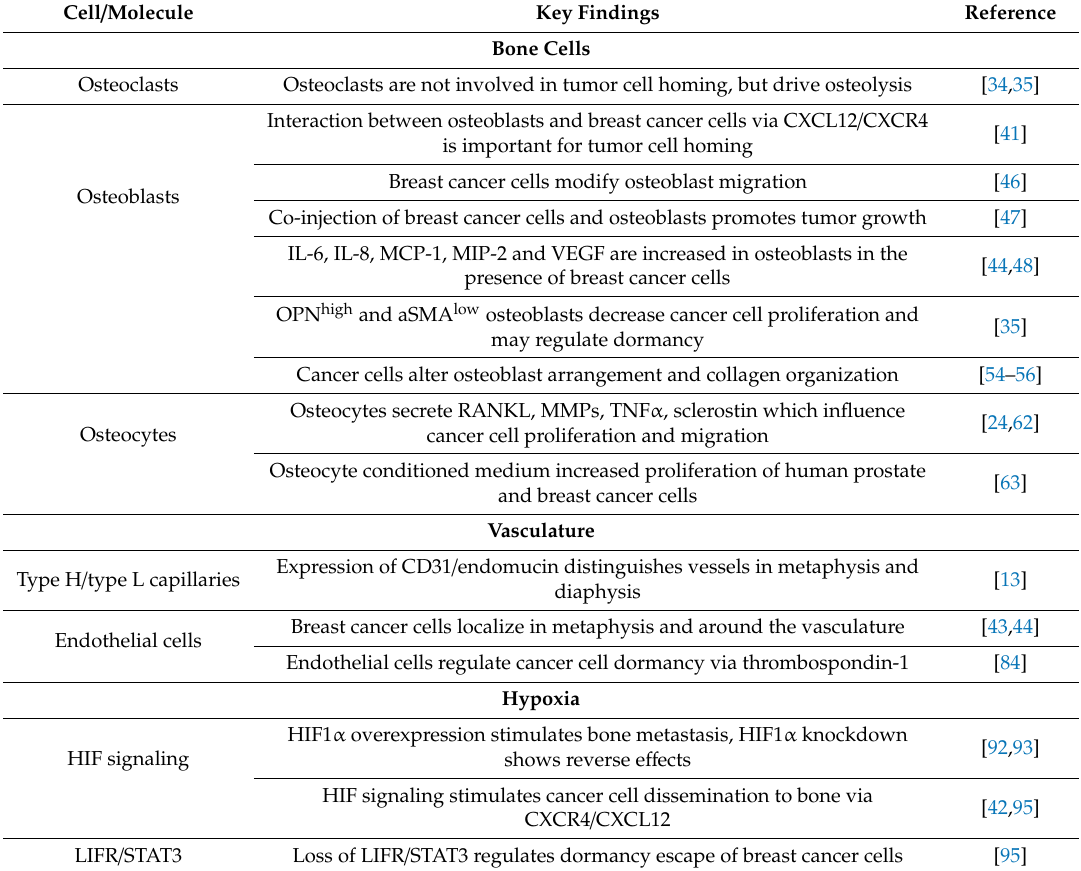
Table 1. Summary of key publications highlighting the contribution of the bone microenvironment to the development and progression of bone